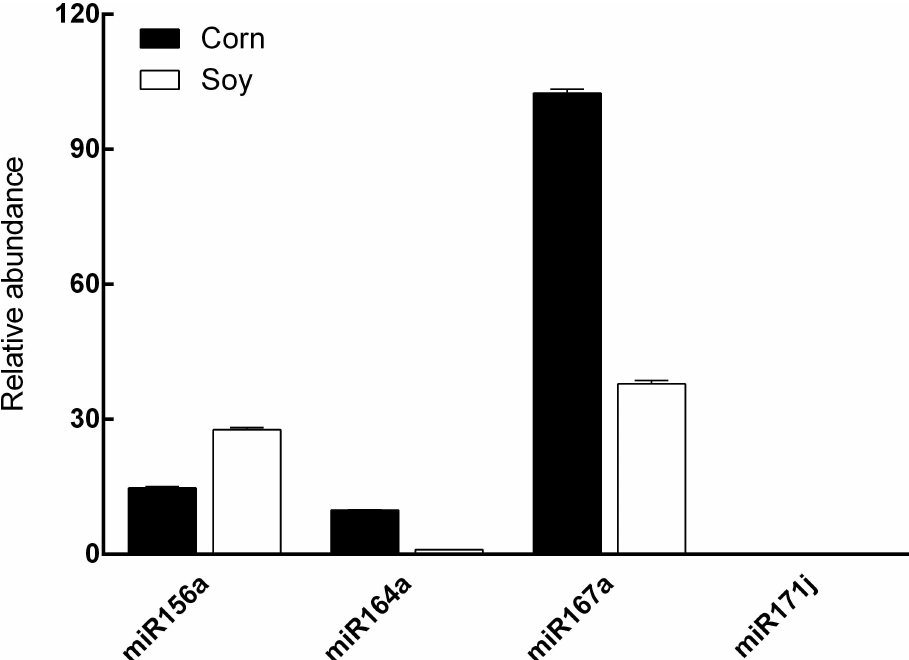
Fig 2. Relative abundance of miR156a, -164a, -167a, and -171j in soy and corn. Expression levels of miRNAs were analyzedby qRT-PCR and relative expressionlevel of miR164a in soy was set as 1 (data presented as Mean ±